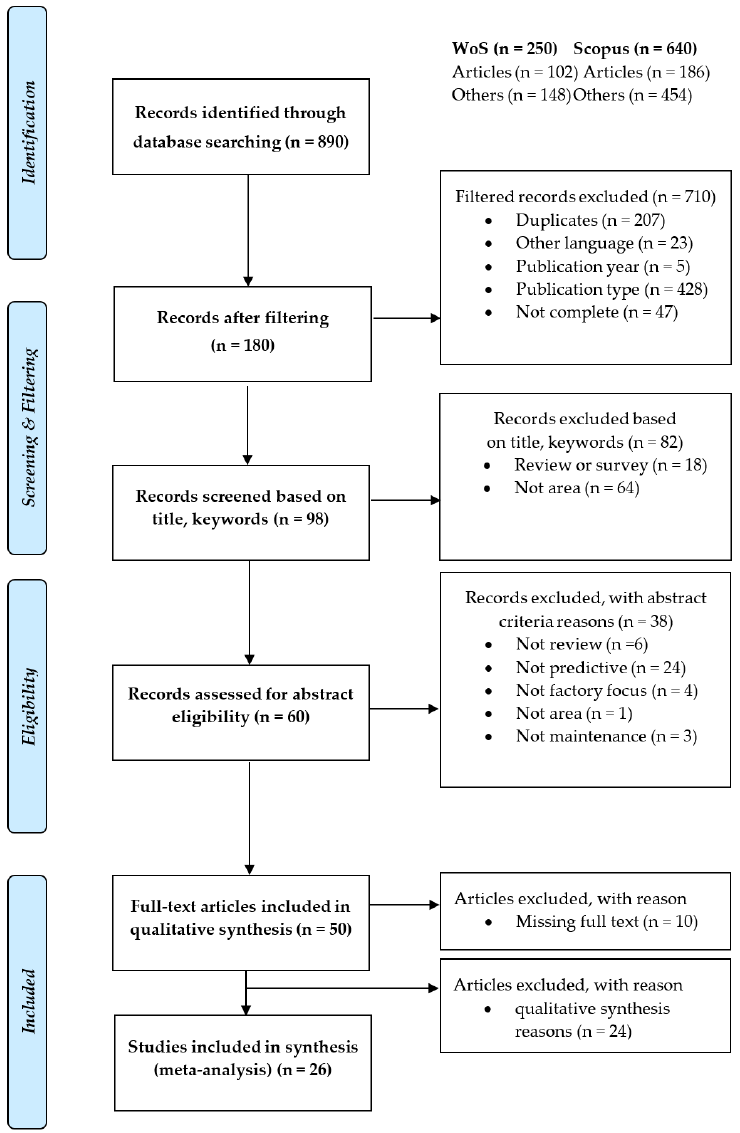
Figure 4. Flow diagram based on PRISMA [48] and QUORUM [49] flowchart.